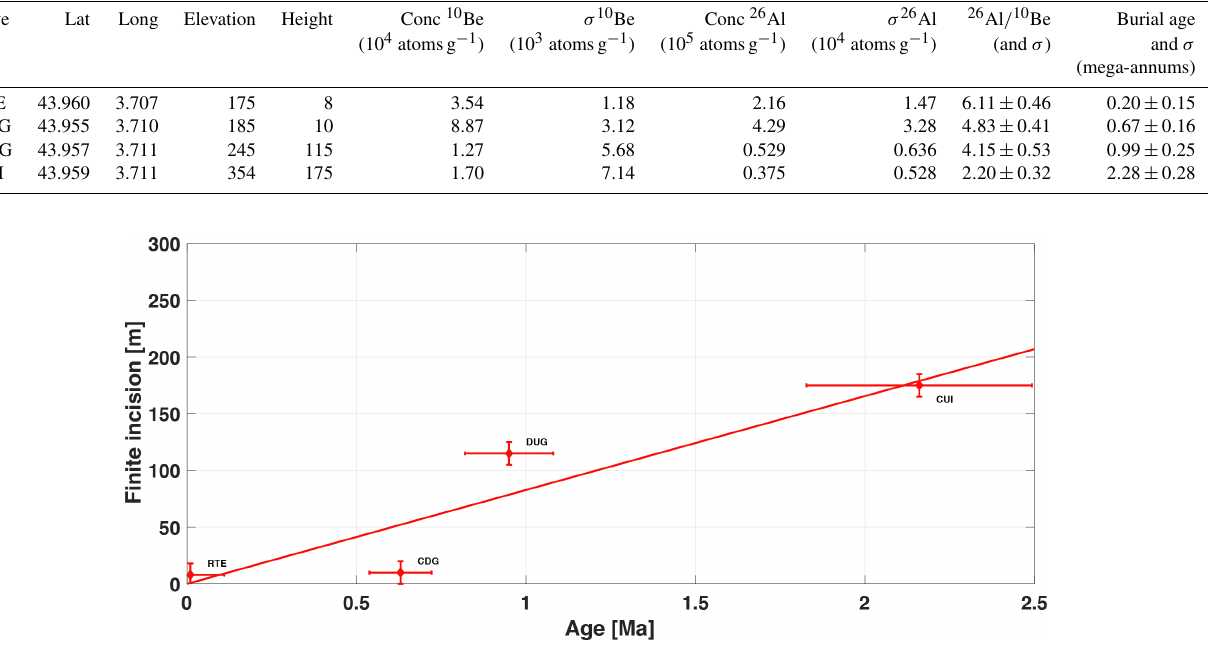
Figure 5. Correlation diagram of finite incision and burial age for the Rieutord canyon (Site 1, Fig. 1). Finite incision is the elevation of the sampling site relative to the current riverbed. RTE for Route Cave, CDG for Camp de Guerre Cave, DUG for Dugou Cave and CUI for Cuillère